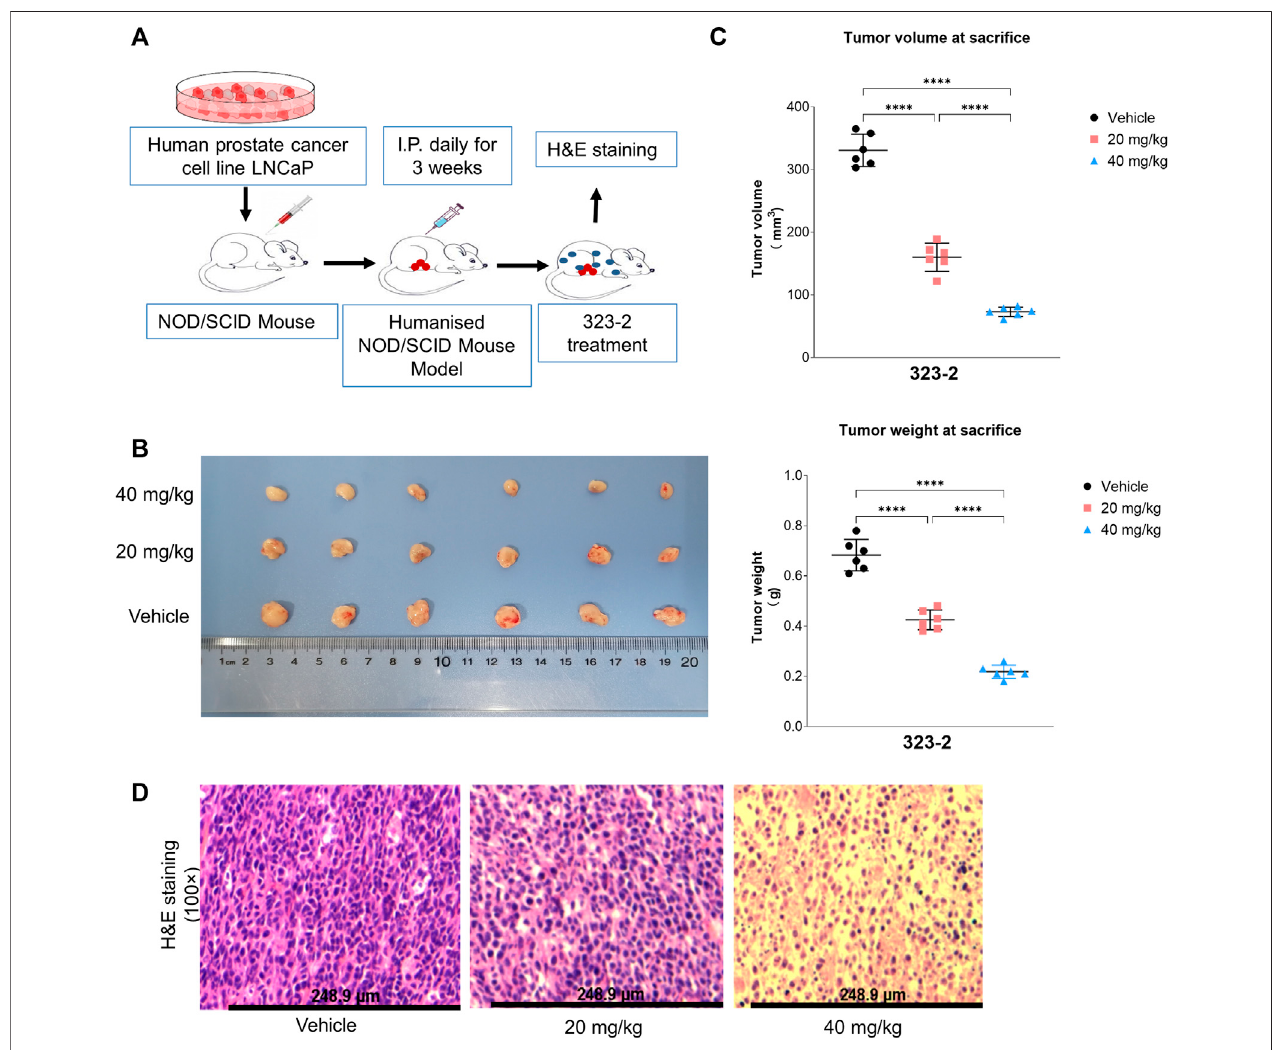
FIGURE 6 | Compound 323s repressed growth of LNCaP xenografts. (A) Work fl ow of the in vivo mouse tumor experiment. LNCaP cells were harvested and resuspended in PBS. A total of 5 × 10 6 cells were subcutaneously injected into the right fl ank of BALB/c-nu nude mice. The mice were treated daily for 3 weeks with IP injections of either the vehicle (olive oil) or the compound 323 – 2 (20 mg/kg or 40 mg/kg in the vehicle). Body weights and tumor volumes were measured before each druginjection.Afterthe22ndday,themiceweresacri fi ced,andthetumorswerecollected,weighed,andstoredat − 70 ° C. (B) PhotographoftheharvestedLNCaP tumors from each group on the day of sacri fi ce. (C) Individual animal tumor volume on the day of sacri fi ce in each group. (D) H&E staining of harvested representative LNCaP tumors in each group. Signi fi cance was determined by using one-way ANOVA multiple comparison. * p ≤ 0.05, ** p ≤ 0.01, *** p ≤ 0.001, and **** p ≤ 0.0001.